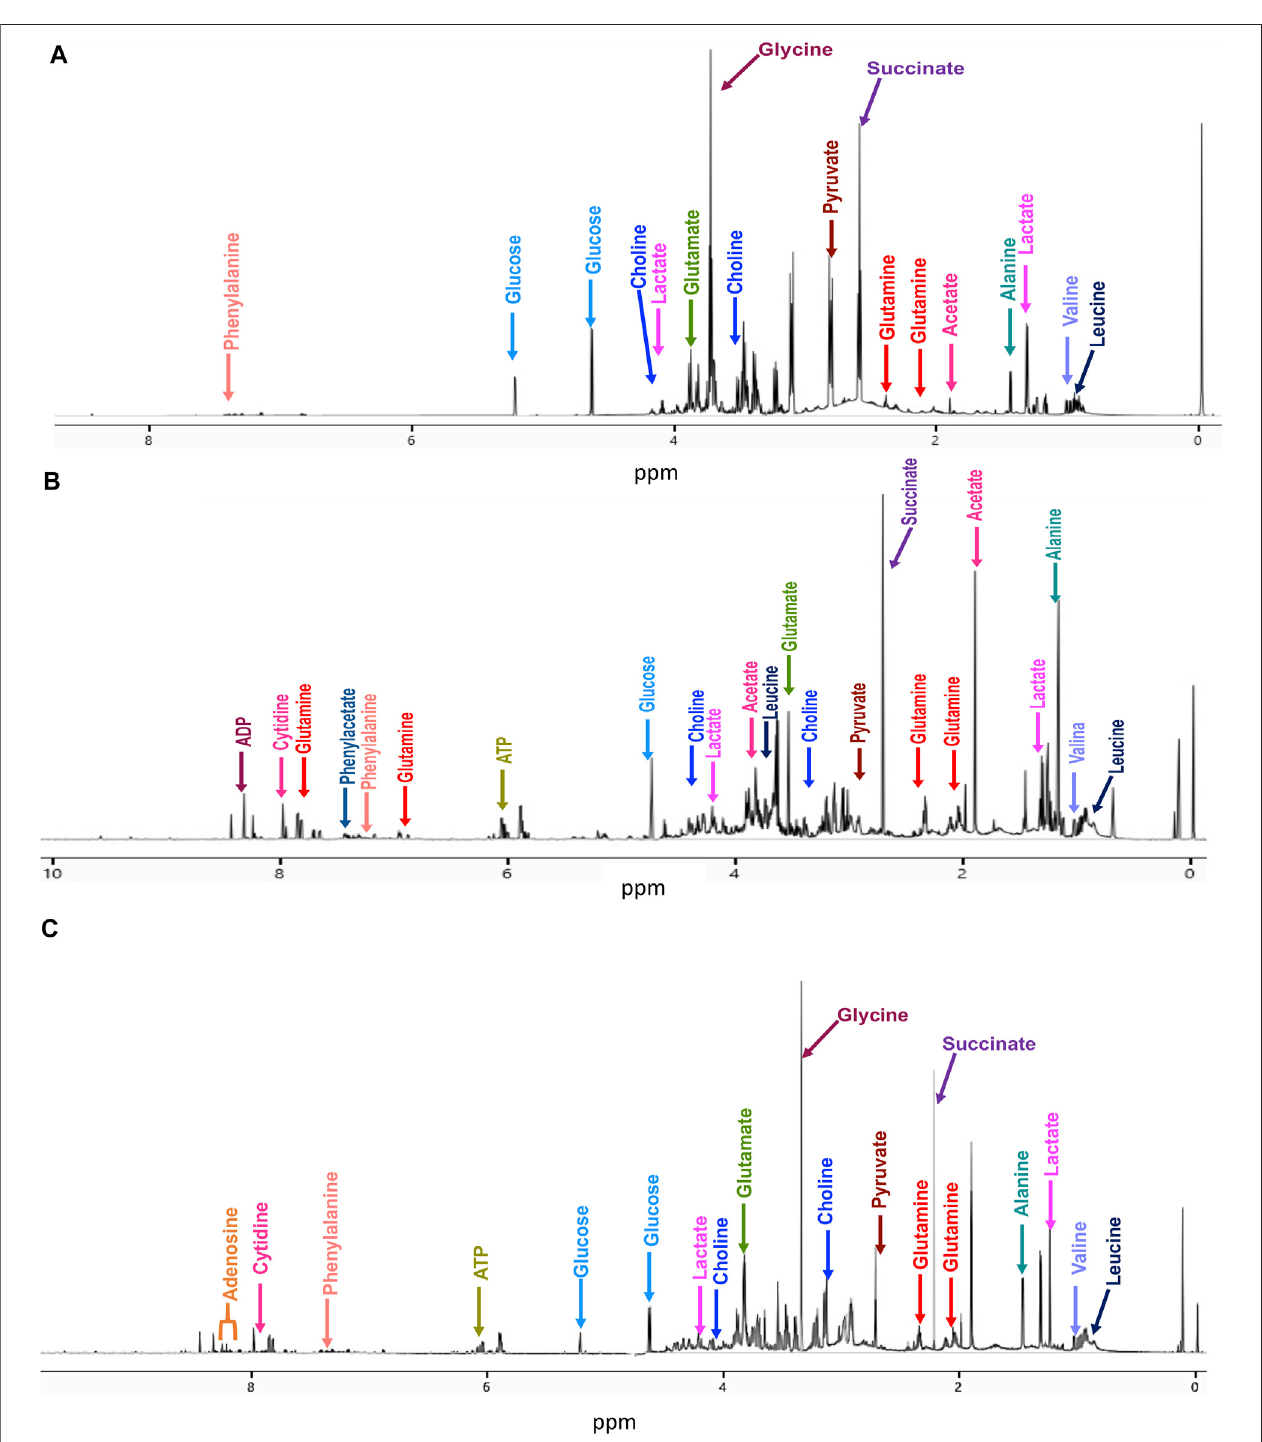
FIGURE 1 | Representative 700 MHz 1 H-NMR spectra with some metabolite assignments at 20 min treatment for (A) untreated cells, (B) cisplatin-treated cells, and (C) CasIIgly-treated cells.